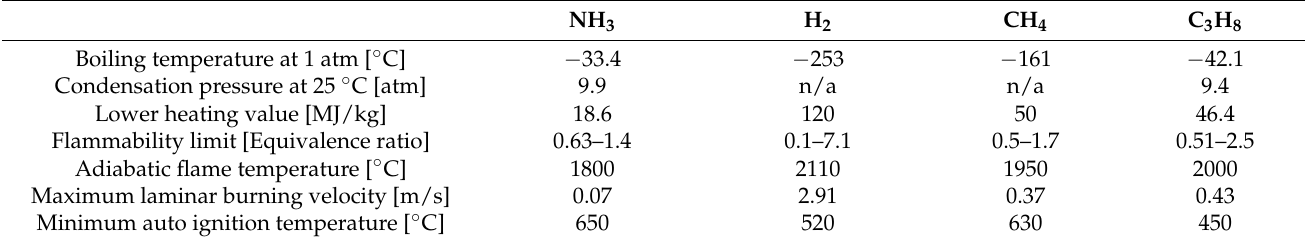
Table 1. Thermodynamic characteristics of ammonia and other hydrocarbon fuels [55].